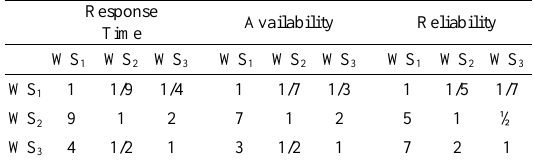
Table 4. Comparison matrices for Case 1.